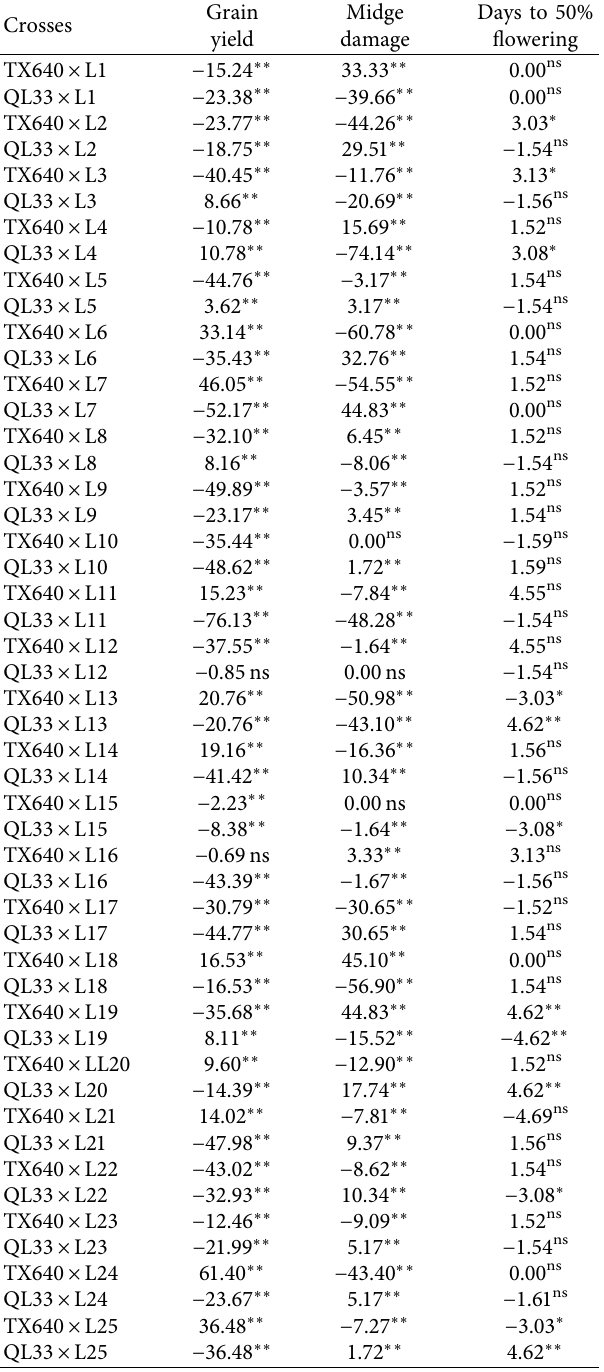
Table 3: Better parent heterosis of 50 experimental hybrids evaluated in the 2015 rainy season.